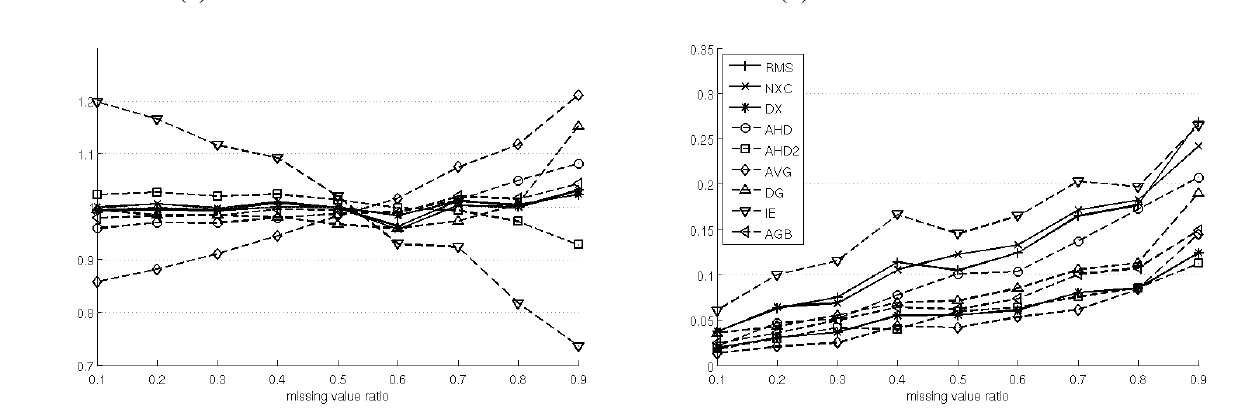
Figure 9. Mean and Standard Deviation of Image Distances for Different Levels of Missing Values. For Each Distance Measure, the Mean Values have been Normalized, so that Their Mean is